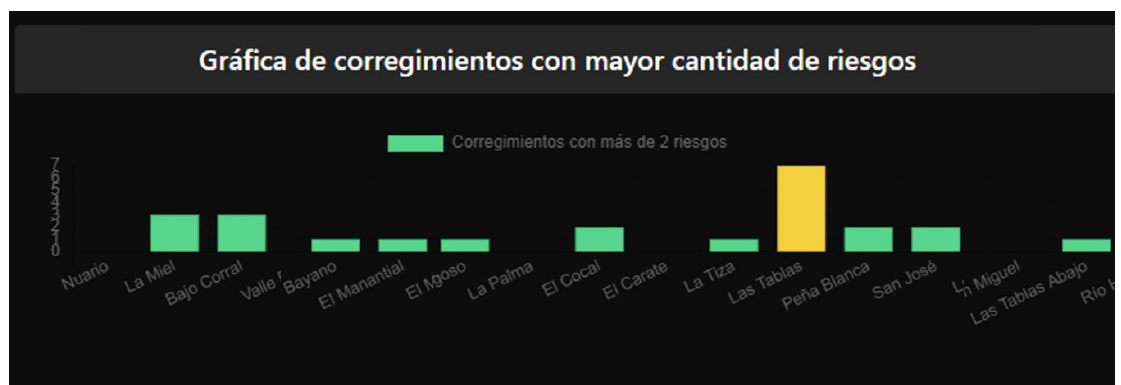
Figure 9. Bar Graph based on municipalities with their risk levels.